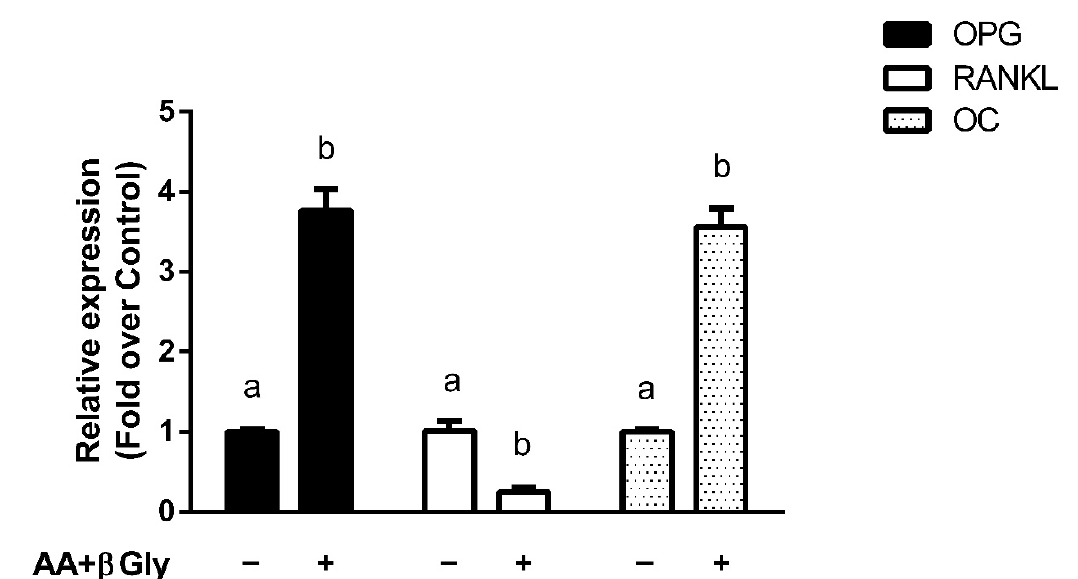
Figure 4. Differentiation of pre-osteoblastic cells induces changes in the expression of bone metabolism marker genes. MC3T3-E1 pre-osteoblastic cells were differentiated to osteoblasts with 50 μ g/mL ascorbic acid (AA) and 10 mM β -glycerophosphate ( β -gly) for 14 days. Osteoprotegerin (OPG), receptor activator of nuclear factor kappa-B ligand (RANKL) and osteocalcin (OC) mRNA levels were quantified by qPCR as described in the methods section. Results are mean +/ − SD of at least three independent experiments performed in triplicates. Statistical significance was denoted using letters above bars. Means indicated with a common letter are not significantly different. Likewise, means not sharing any letter are significantly different.